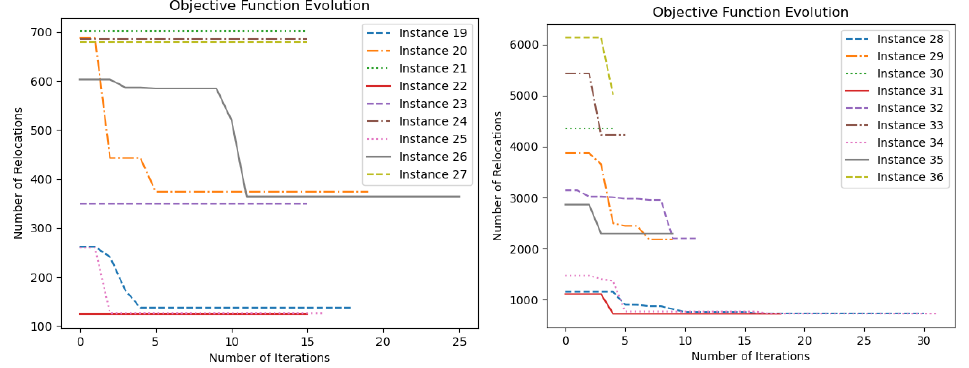
Figure 11. Evolution of the objective function of small- and medium-sized instances.